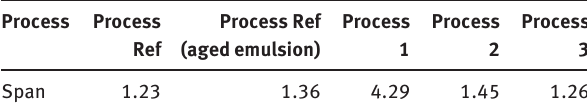
Figure 3 Characteristic droplet sizes of